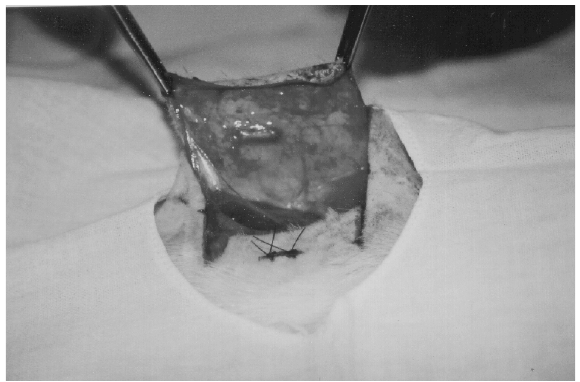
FIGURA 2 - Biópsia do tecido, com tubo implantado ao centro do